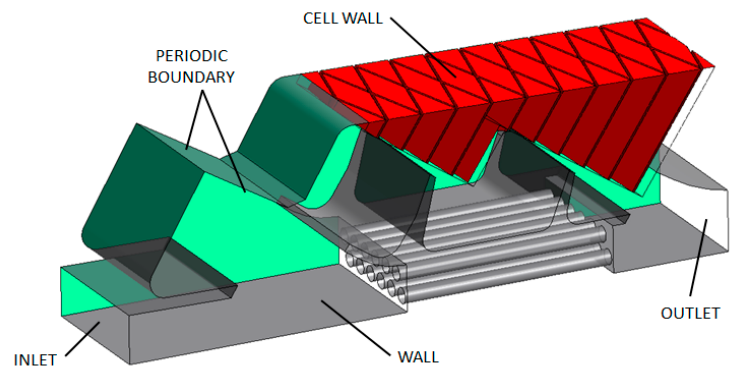
Figure 11. Test Article (TA), boundary conditions.